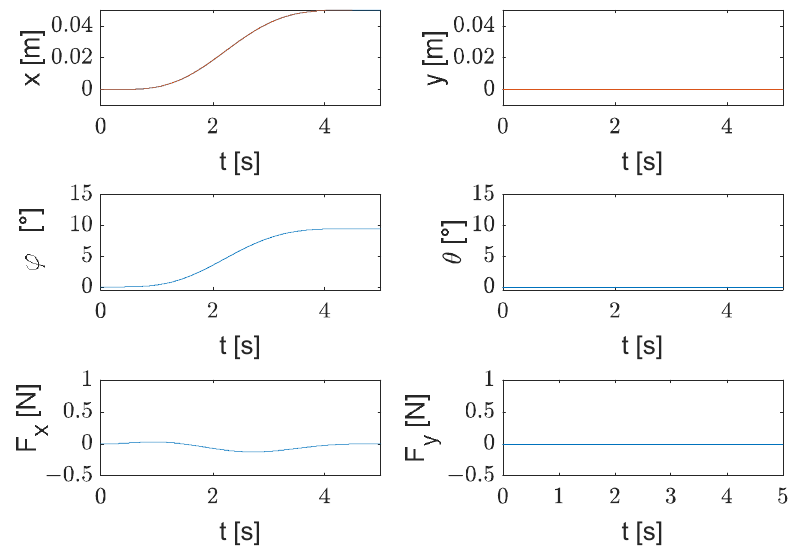
Figure 23. Response for an abduction movement ϕ = 9.45 ◦ , x = 0.05 m, without disturbance.